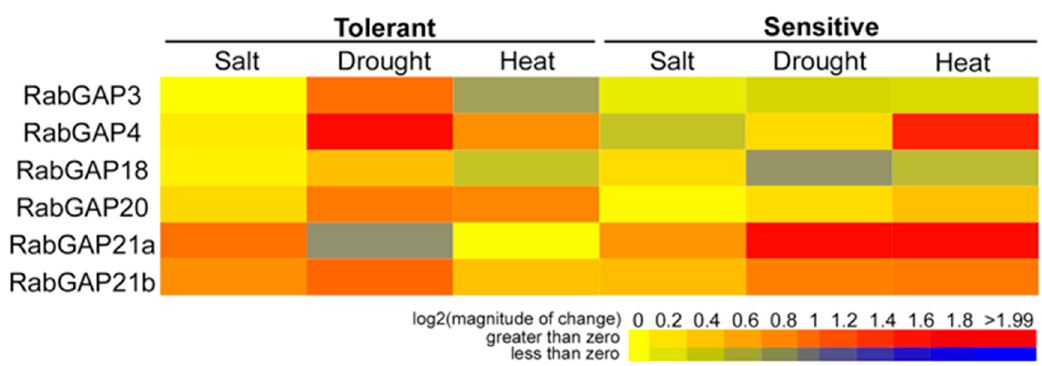
Figure 7. Transcriptomic profiles of RabGAP genes from tomato species with different degrees of abiotic stress tolerance. Expression patterns of RabGAP genes in S. lycopersicum (sensitive species) and S. pimpinellifolium or S. habrochaites (tolerant species) in saline, drought and heat stress are represented. Higher or lower gene expressions versus the control, without stress, are shown in red and dark blue, respectively. Saline stress: S. lycopersicum versus S. pimpinellifolium (GEO accession GSE16401). RNA extraction from leaves of 6-week-old plants treated with NaCl 200 mM for 5 h [46]. Stress by drought: S. lycopersicum versus S. habrochaites (GEO accession GSE22304). Extraction of RNA from leaves of four-week-old plants, previously without irrigation for 14 days. Heat stress: S. lycopersicum versus S. habrochaites (GEO accession GSE22304). RNA extraction from leaves of four-week-old plants treated at 40 °C [47]. All values are detailed in Table S7.